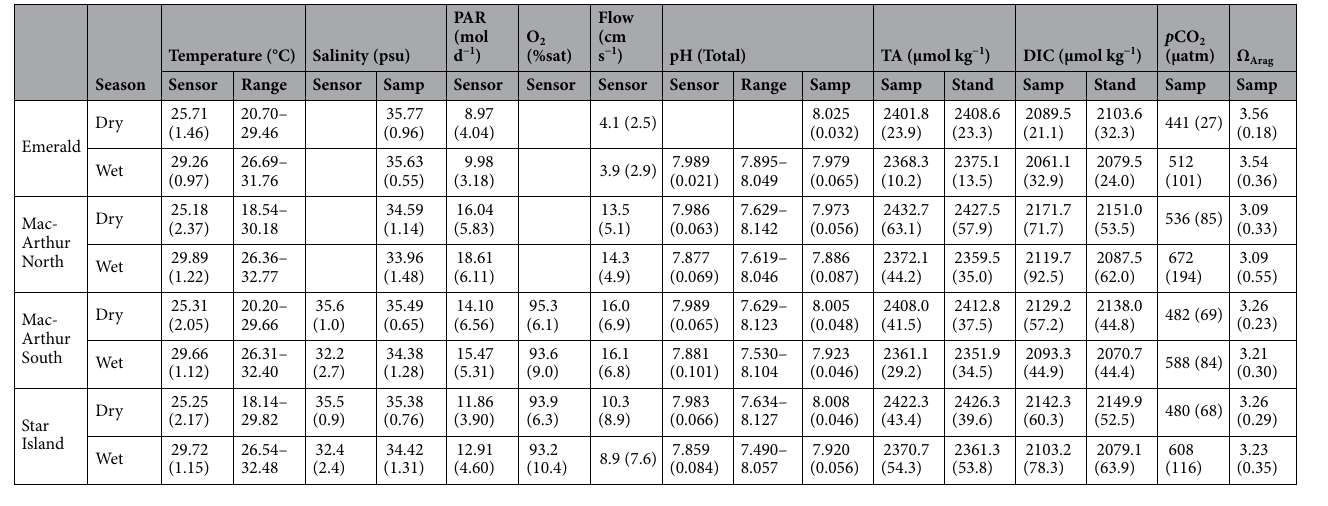
Table 1. Environmental conditions at a natural coral reef (Emerald) and three inshore urban sites (MacArthur North, MacArthur South, and Star Island), separated by season (Wet and Dry). Values are means with standard deviations in parentheses, unless denoted as ranges. Values marked as Sensor are collected from instrumentation and those marked as Samp. are from discrete samples. Data marked as Stand. are salinity- standardized. Empty cells indicate periods and locations where data was not collected. The partial pressure of CO 2 (p CO 2 ) and the saturation state of aragonite (Ω Arag ) are calculated from total alkalinity (TA) and dissolved inorganic carbon (DIC). PAR is photosynthetically active radiation expressed as a daily